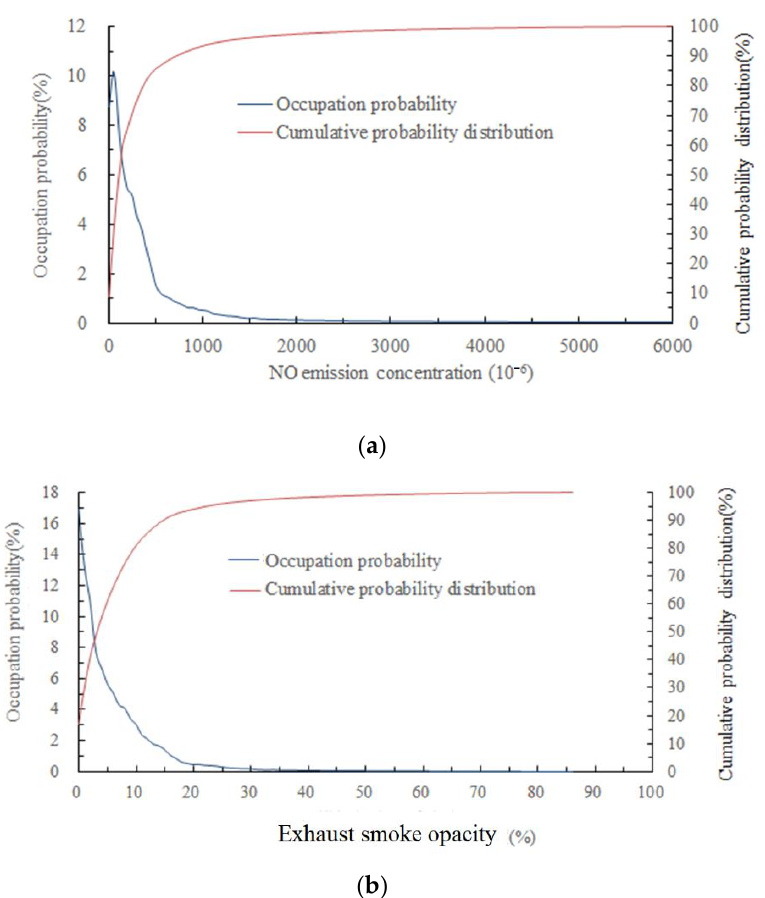
Figure 4. Statistical analysis of remote sensing test data of diesel vehicle emissions. ( a ) NO emissions. ( b ) Exhaust smoke opacity.